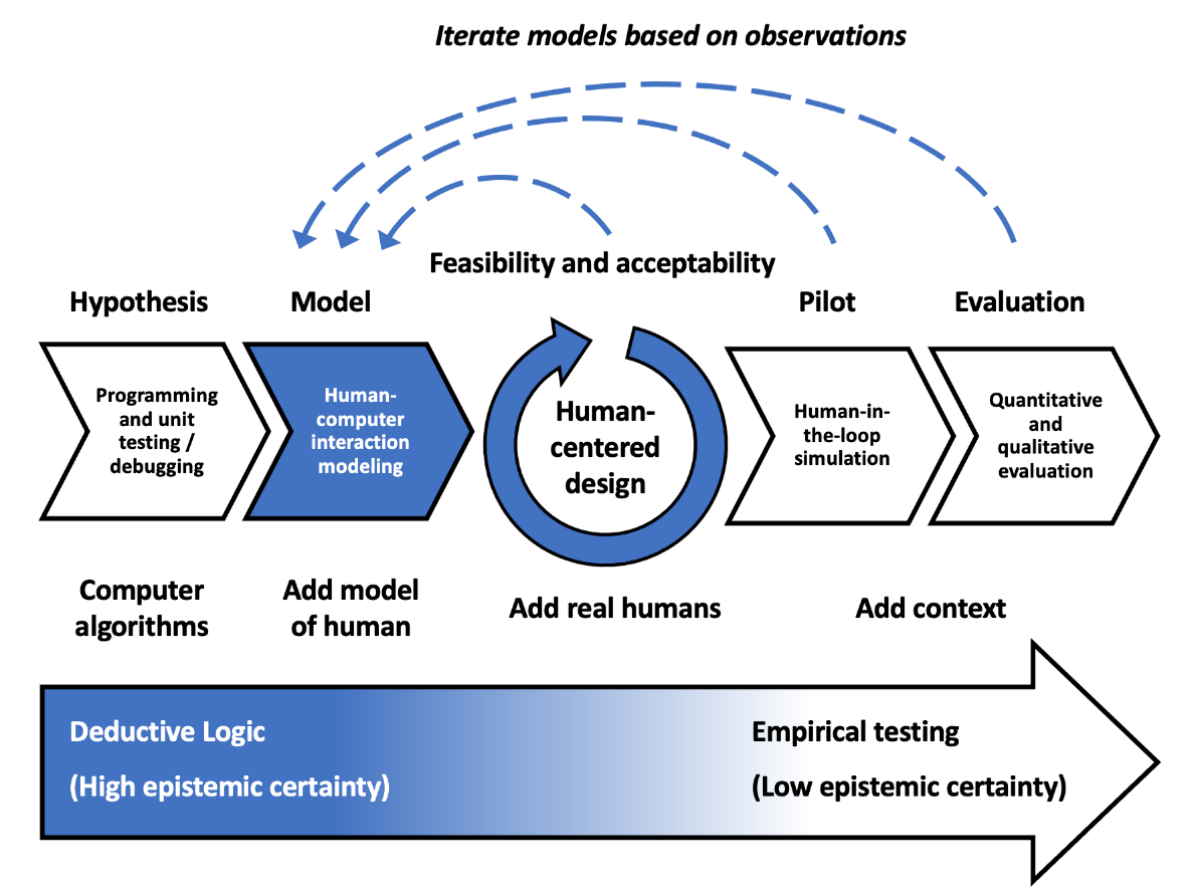
Figure 3. Predictive human-computer interaction modeling could augment the human-centered design process and help us understand how an application achieves real-world